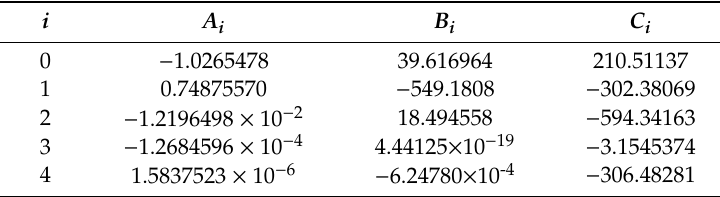
Table A2. Values of A i , B i , and C i for saturated vapor pressure.